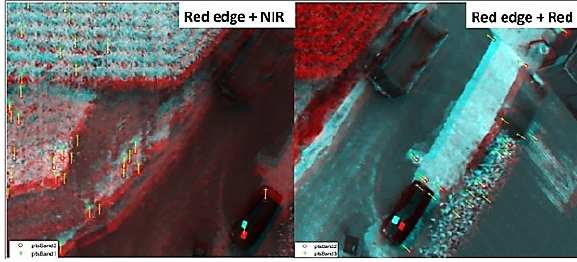
Figure 11. Showing image level systematic displacement The red edge and NIR combination exhibited a displacement of about 11 pixels in the “Y” direction. The red edge and red showed a shift of about 6 pixels in both directions. The last combination, red edge and green, unveiled a uniform displacement of about 6 pixels in the “X” direction. At the image level, misregistration is reduced from an average of 10 pixels to 0.28 pixel. The co-registration results at the image level within same epoch are presented in Table 6.